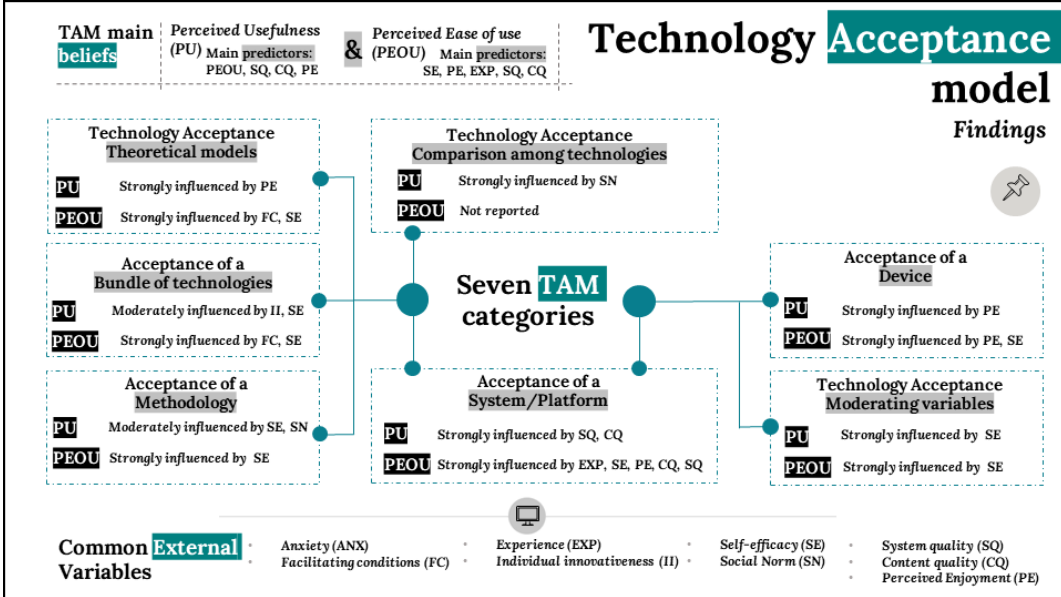
Figure 8. Summary of